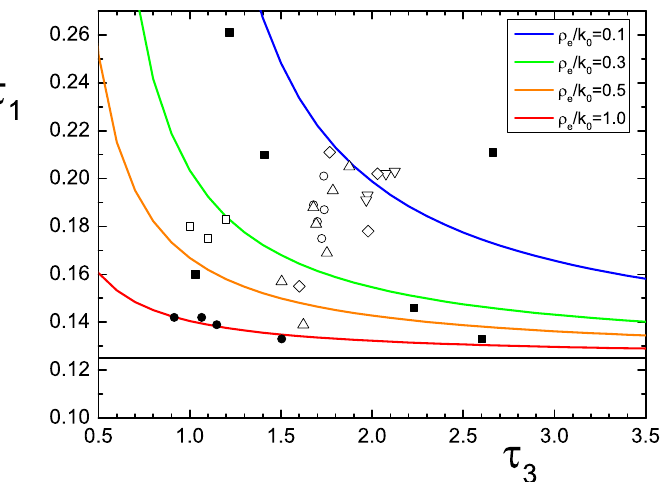
Figure 3. Relationship between τ 1 and τ 3 lifetimes for some values of ρ e / k 0 (each represented by a di ff erent color). Known experimental data of materials listed in Table 1 are represented by black circles, for data respecting the intensity rule, and by black squares for the other data. Known experimental data of the series of materials listed in Table 2 are represented by open symbols, as in table. Straight black line represents the p -Ps lifetime in vacuum (0.125